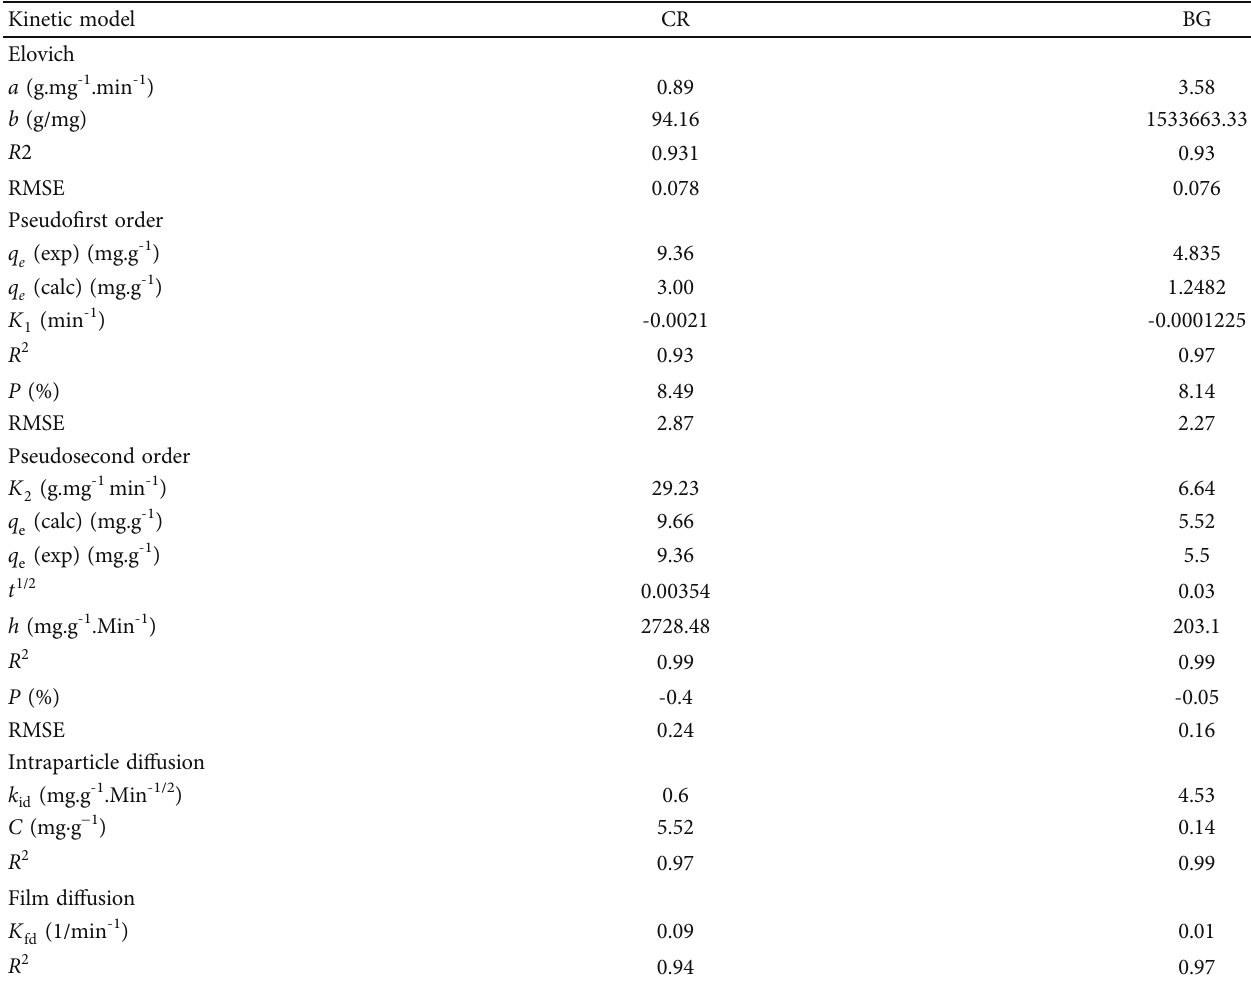
Table 4: A brief summary of kinetic parameters applied on adsorption of dyes on BO.